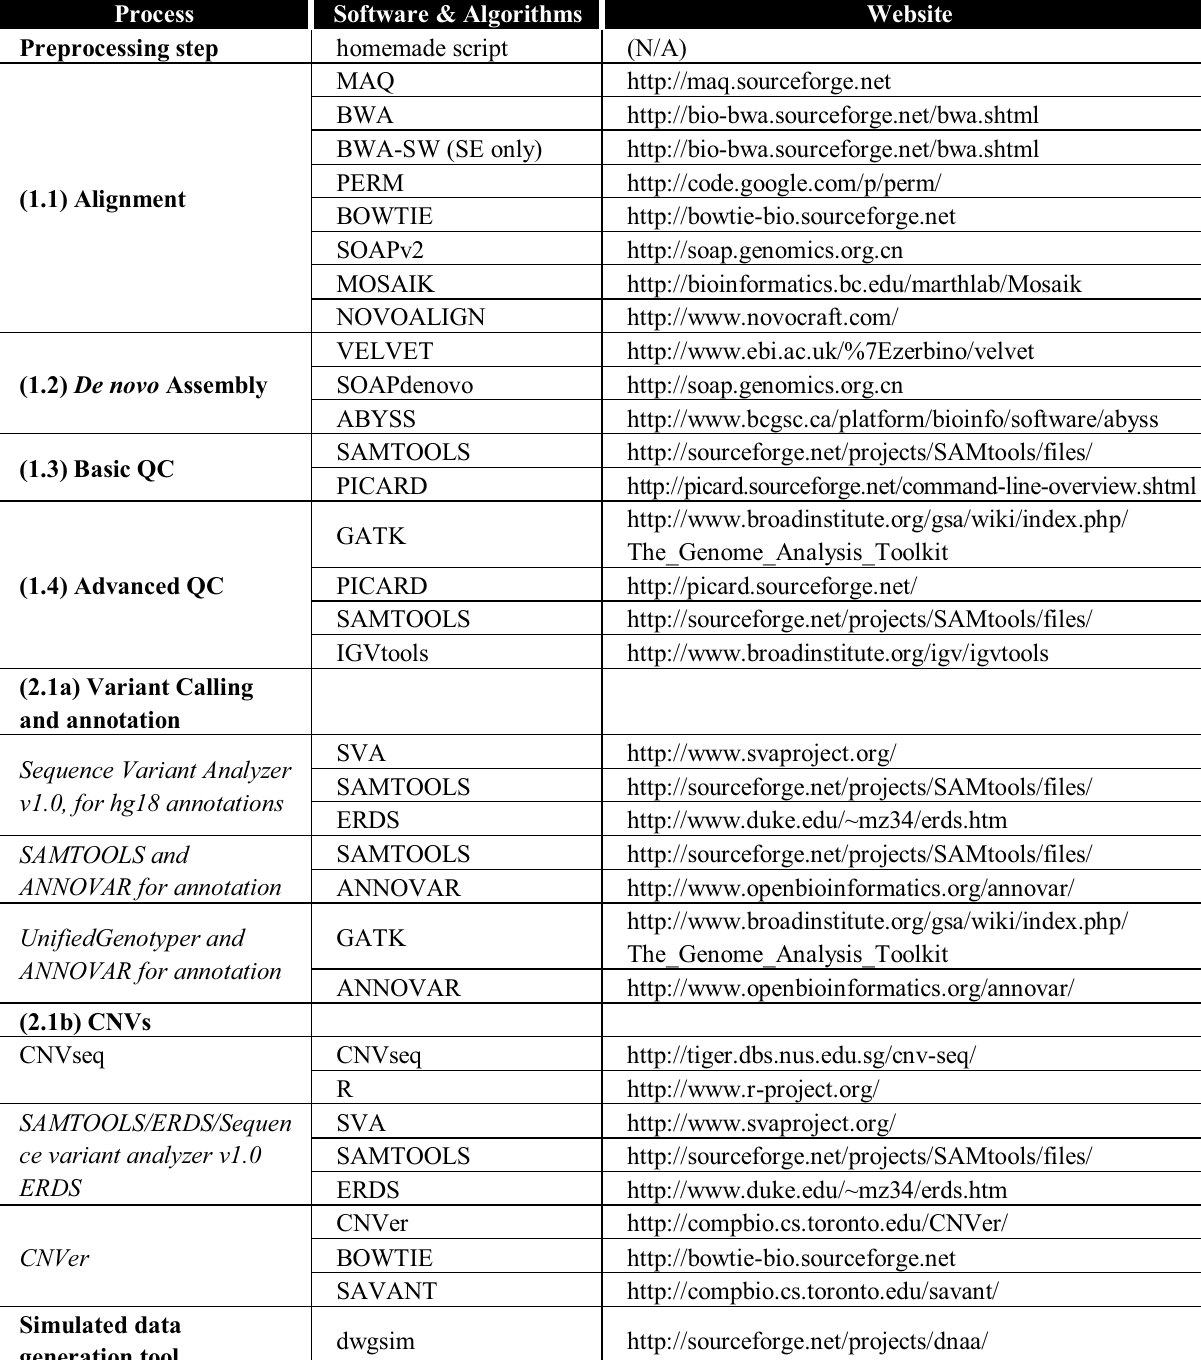
Table 1. Review of the most used software in next-generation sequencing (NGS) data analysis. Which includes two major computational macro-processes: (1) a primary step related to mapping and assembling, with alignment quality control, quality score re- (cid:70)(cid:68)(cid:79)(cid:76)(cid:69)(cid:85)(cid:68)(cid:87)(cid:76)(cid:82)(cid:81)(cid:15)(cid:3)(cid:85)(cid:72)(cid:68)(cid:79)(cid:76)(cid:74)(cid:81)(cid:80)(cid:72)(cid:81)(cid:87)(cid:3)(cid:76)(cid:81)(cid:3)(cid:179)(cid:71)(cid:76)(cid:73)(cid:73)(cid:76)(cid:70)(cid:88)(cid:79)(cid:87)(cid:180) regions of the genome; and (2) secondary, advanced steps focused on variant (single nucleotide polymorphisms (SNPs), insertions-deletions (Indels) and copy number variations (CNVs)) calling and annotation. These macro-processes are briefly reviewed to provide a background for the software algorithms embedded in DNA-Seq